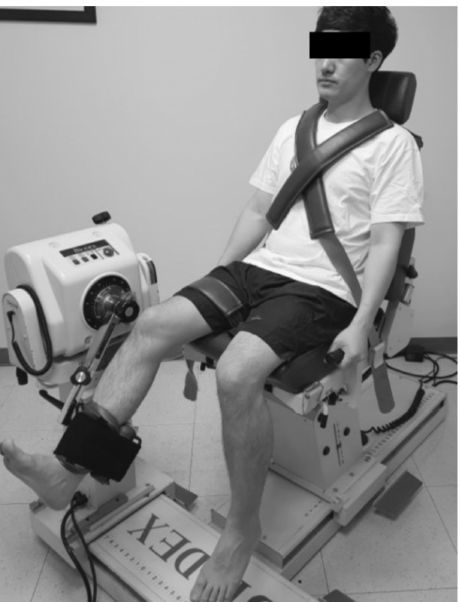
Figure 2. Measurement of hamstrings and quadriceps muscle